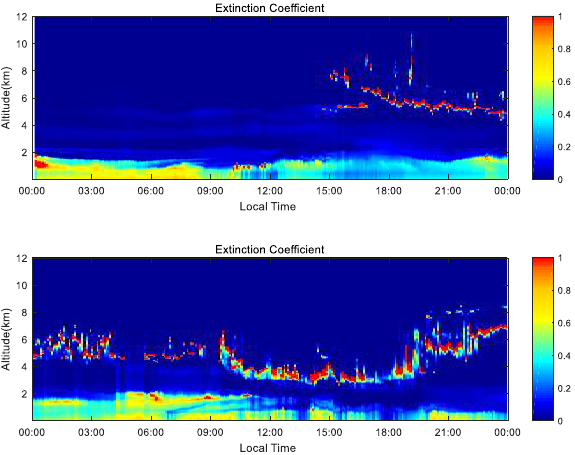
Figure 10. Aerosol extinction coefficient